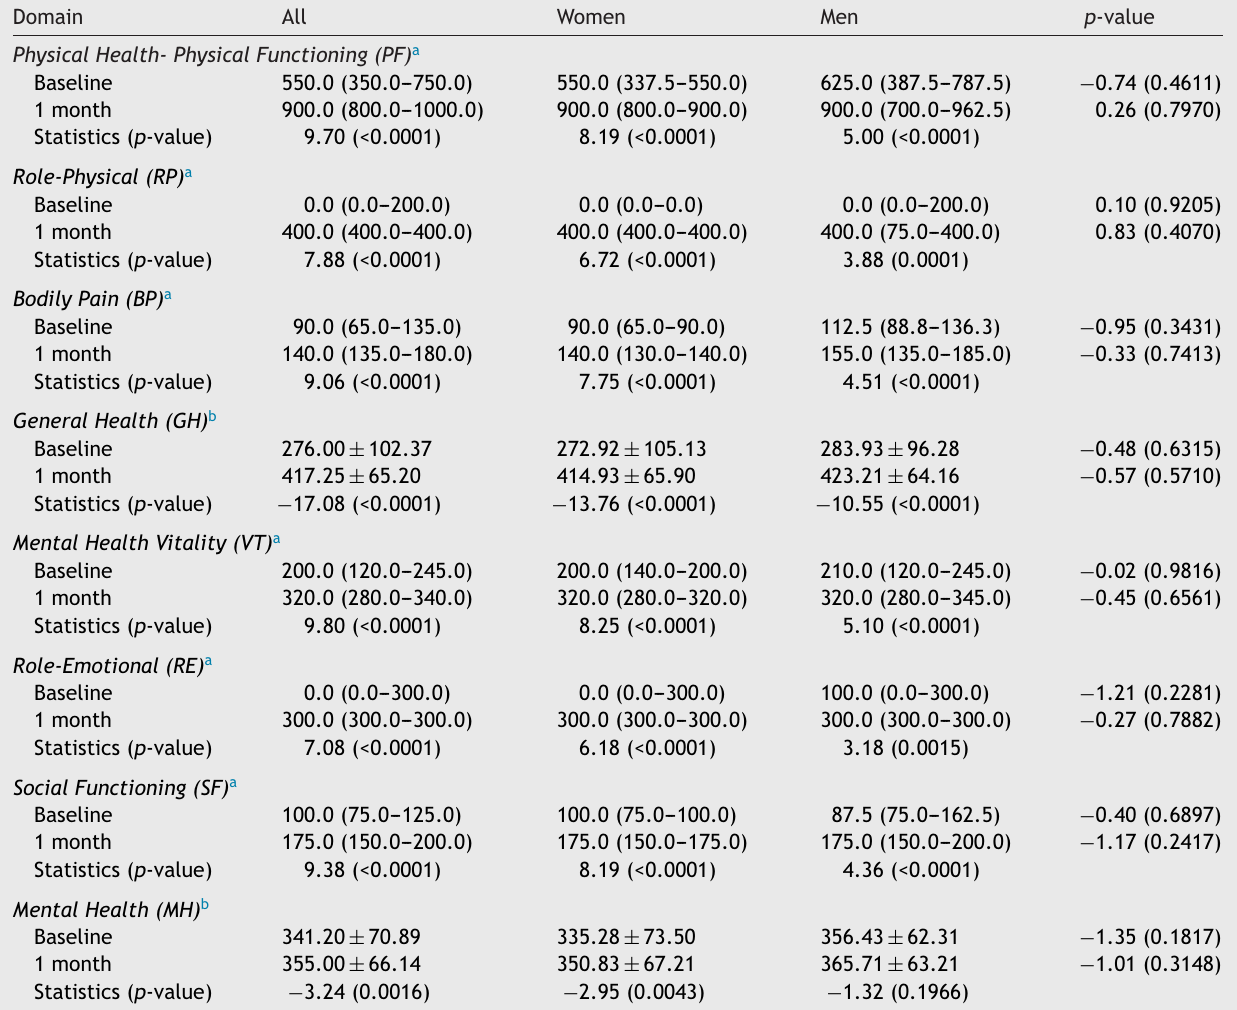
Table 2 SF-36 scores at the baseline and 1